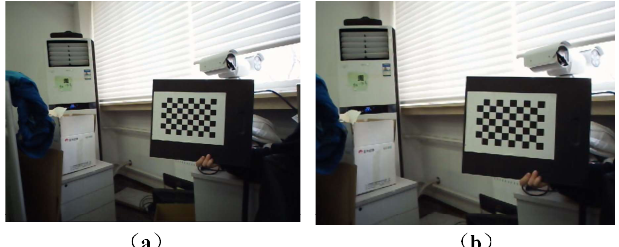
Figure 4. Checkerboard before and after distortion correction: ( a ) Before distortion correction; ( b ) After distortion correction.